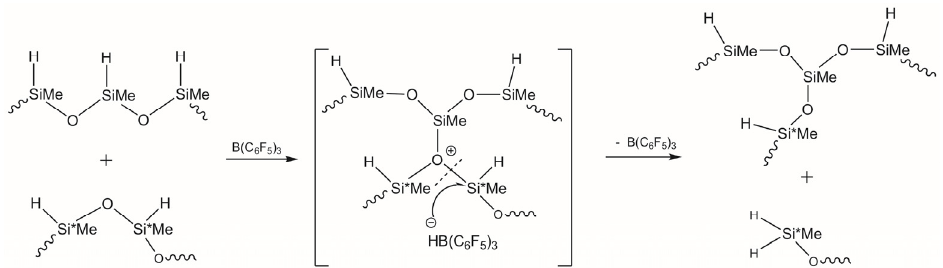
Figure 4. Cyclic oligomers’ formation and disappearance during the restructuring of PHMS in its 20% solution in toluene in the presence of 1 × 10 − 2 mol/L of (C 6 F 5 ) 3 B at 30 °C.